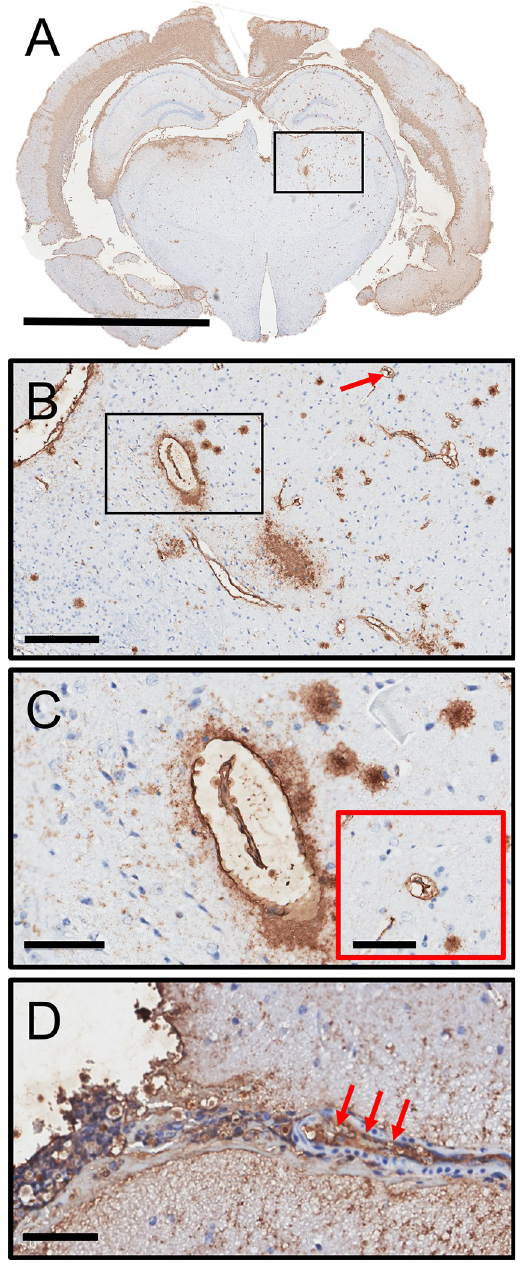
Fig 10. C . neoformans GXM abundantly localizes in the vasculature. (A) Representative GXM immunohistochemistry (IHC) with mAb 18B7 of a coronal brain section of a mouse infected in the right ventricle with C . neoformans . Scale bar: 2 mm. (B) Magnification of the small box in A shows specific localization of GXM in capillaries (red arrow) and blood vessels (black rectangle) of the thalamus. Scale bar: 200 μ m. (C) Magnification of the black rectangle in B demonstrates substantial GXM deposition (brown stain) in the wall and the surroundings of a medium size blood vessel and several capillaries. Scale bar: 60 μ m. Inset shows capsular polysaccharide around a capillary. Scale bar: 10 μ m. (D) Extensive accumulation of GXM in the wall of an artery (red arrows) near the subarachnoid space. Scale bar: 60 μ m.